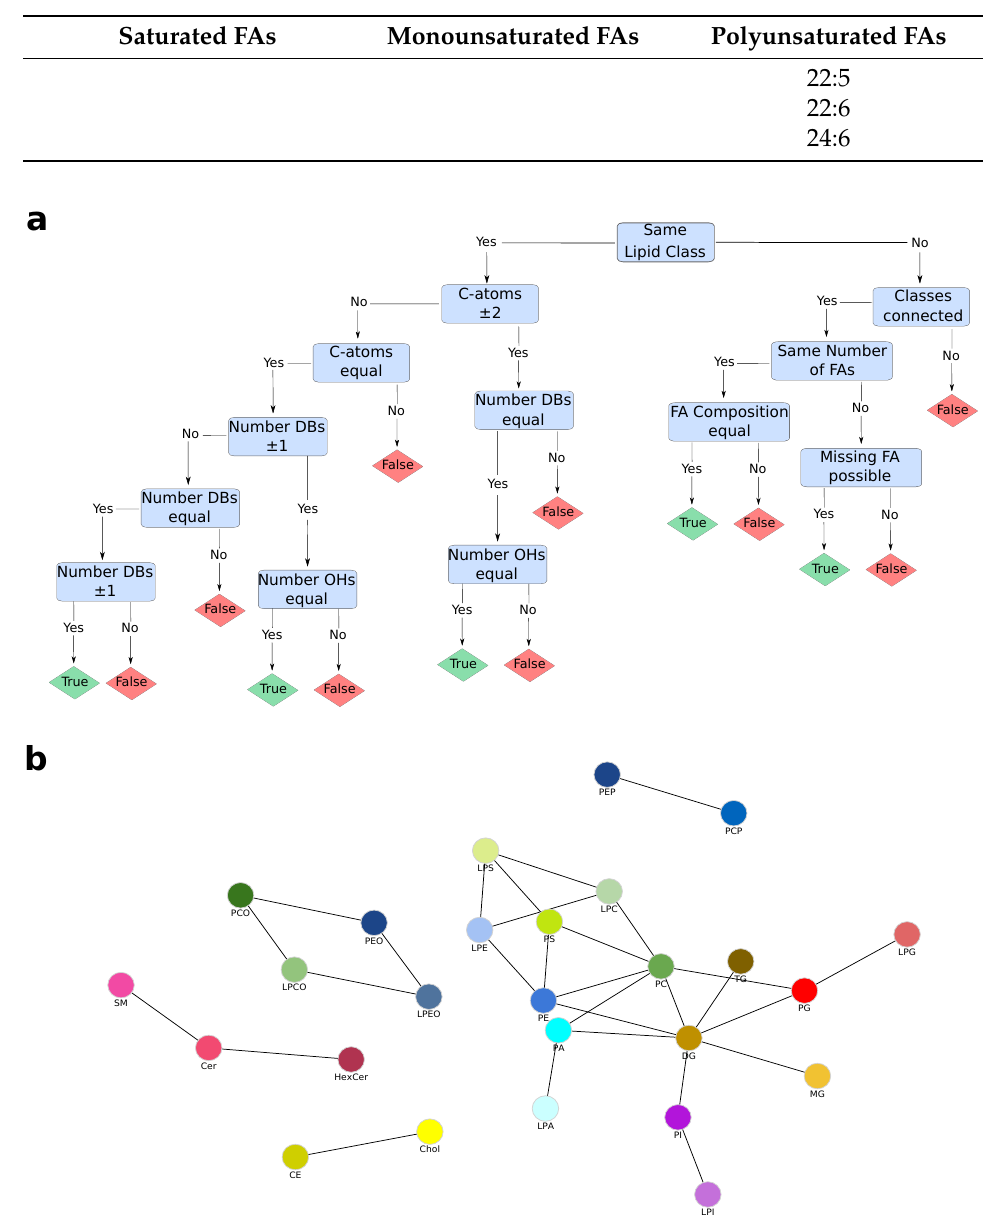
Figure A1. LINEX Default Reaction Rules. ( a ) Decision workflow for lipid connections with default fatty acid reaction rules. Due to the internal logic, lipid classes with different numbers of fatty acids have to have the same head group if they are connected. ( b ) Default lipid class connections. PEP: PE—Plasmalogen; PCP: